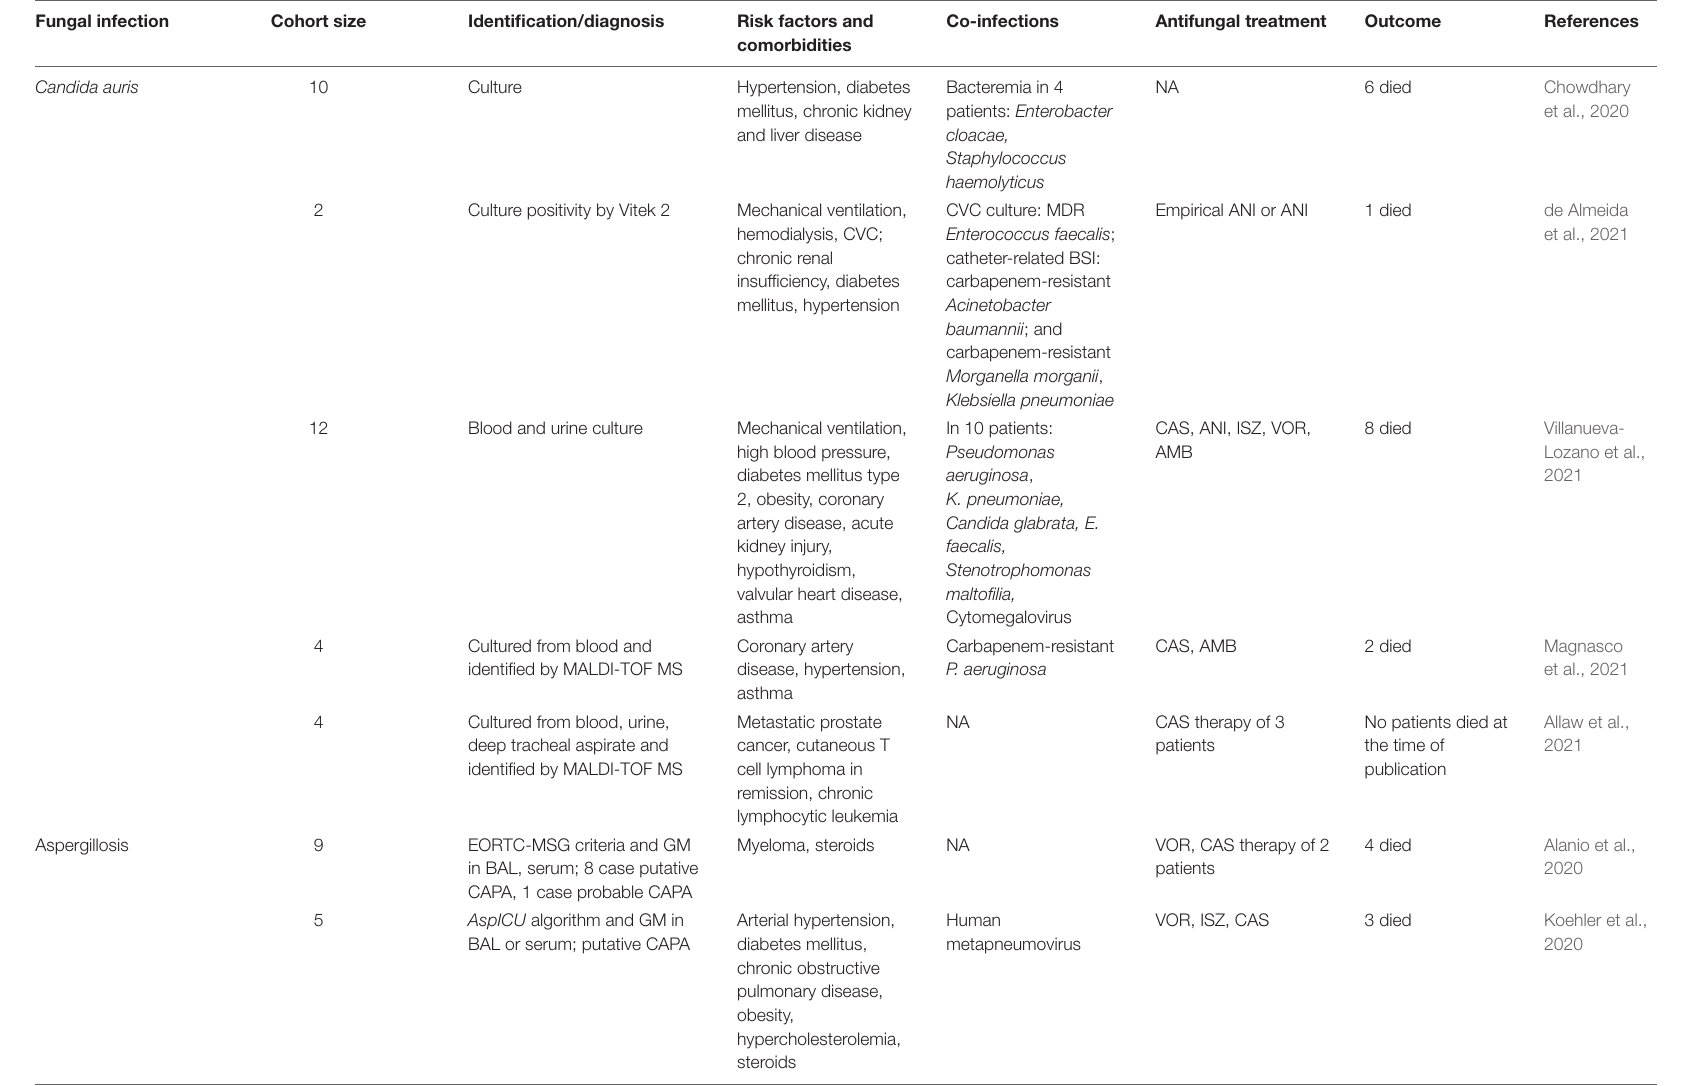
TABLE 1 | Comparison of the characteristics of COVID-19-associated fungal infections. Fungal